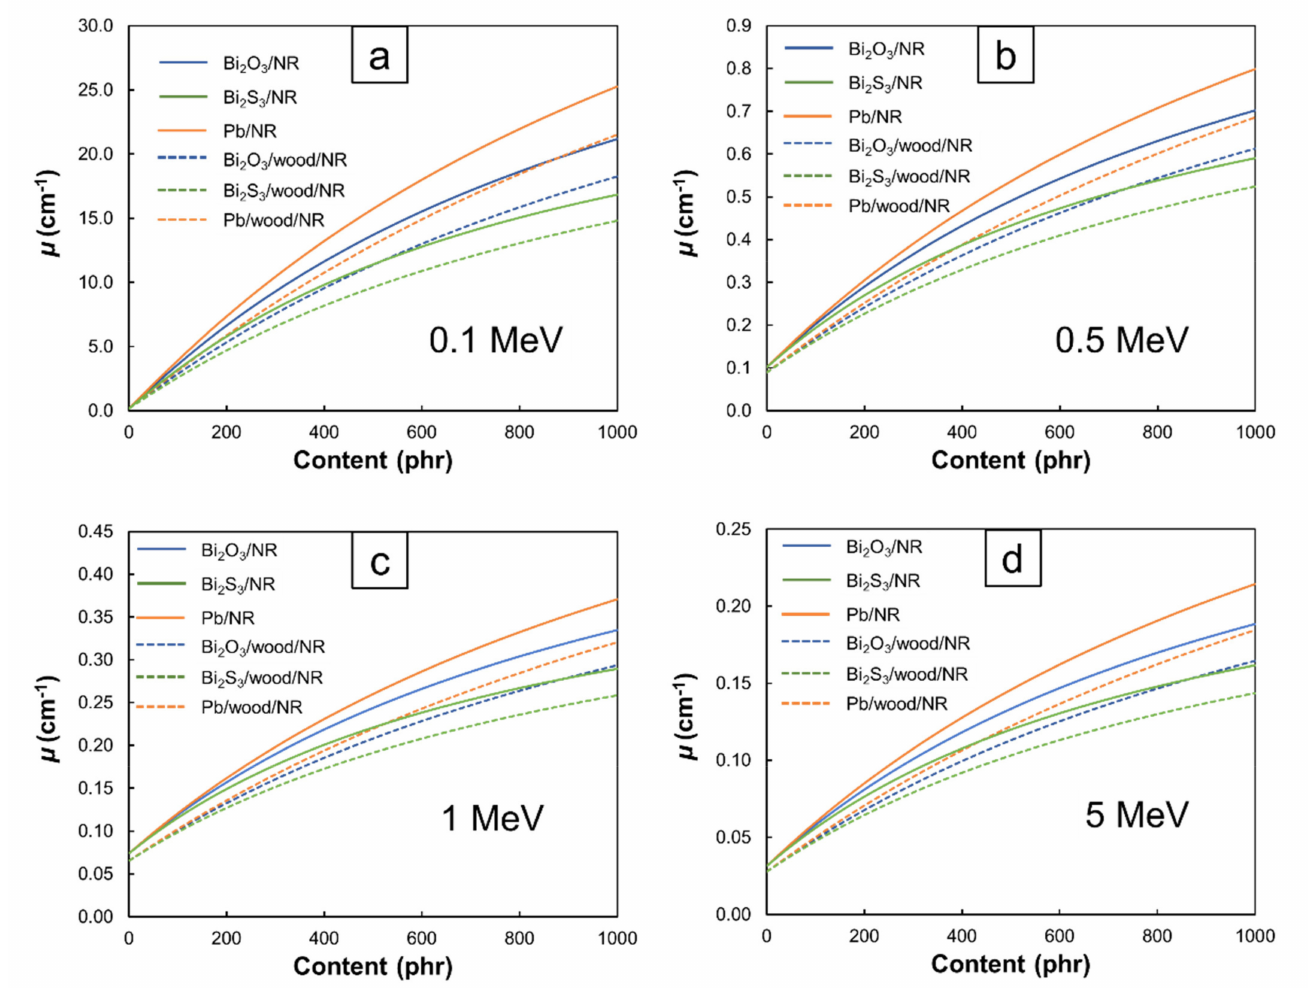
Figure 7. µ values of Bi 2 O 3 /NR, Bi 2 S 3 /NR, Pb/NR, Bi 2 O 3 /wood/NR, Bi 2 S 3 /wood/NR, and Pb/wood/NR composites at photon energies of ( a ) 0.1 MeV, ( b ) 0.5 MeV, ( c ) 1 MeV, and ( d ) 5